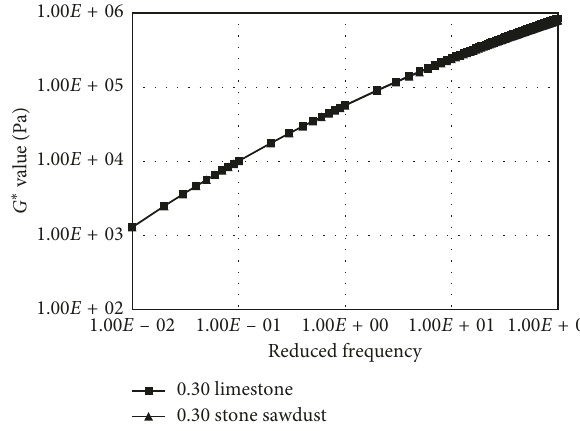
Figure 22: G value master curve for the two mastics (VR ∗